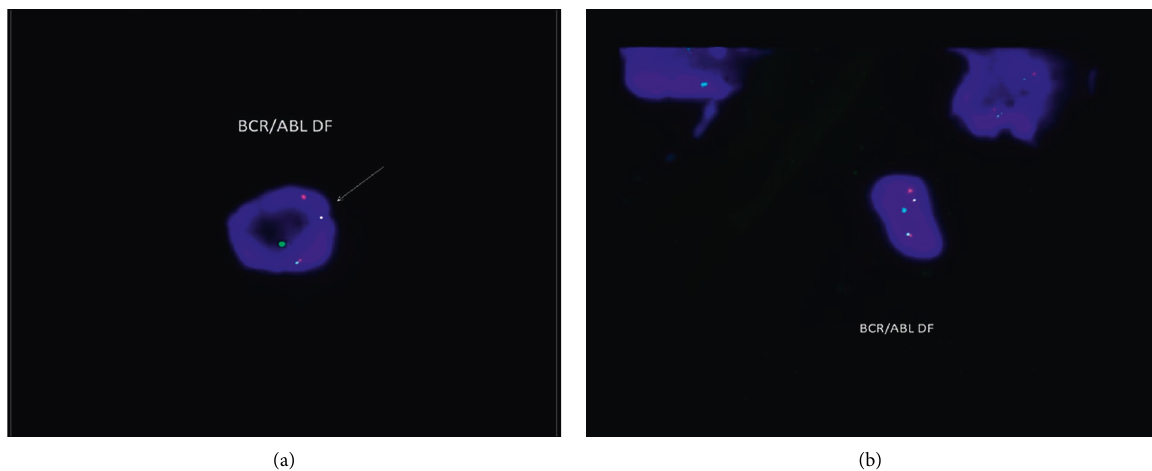
Figure 5: FISH showing positive BCR/ABL1 translocation. (a) Fusion signal in a cell with morphologic feature of blast. (b) Fusion signal in a cell with morphologic features of a band neutrophil.